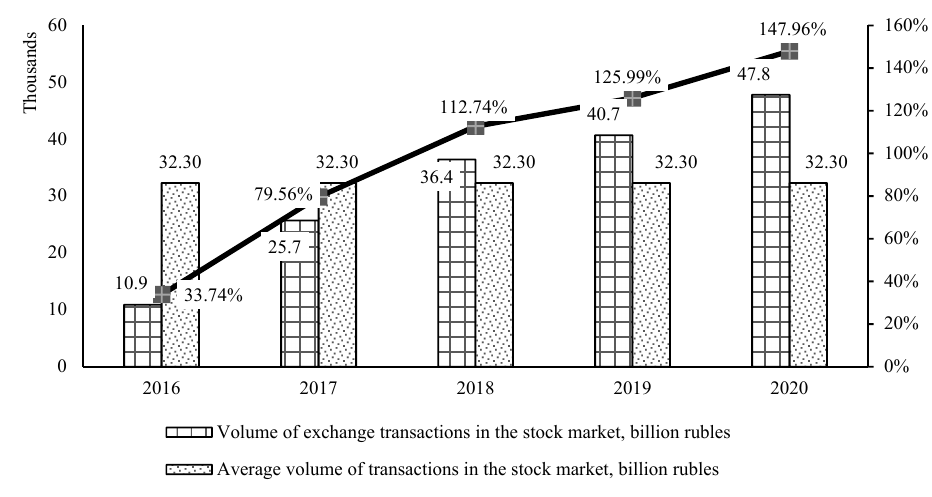
Figure 4. Dynamics of the stock market development Indicator 2 and its components in the Russian